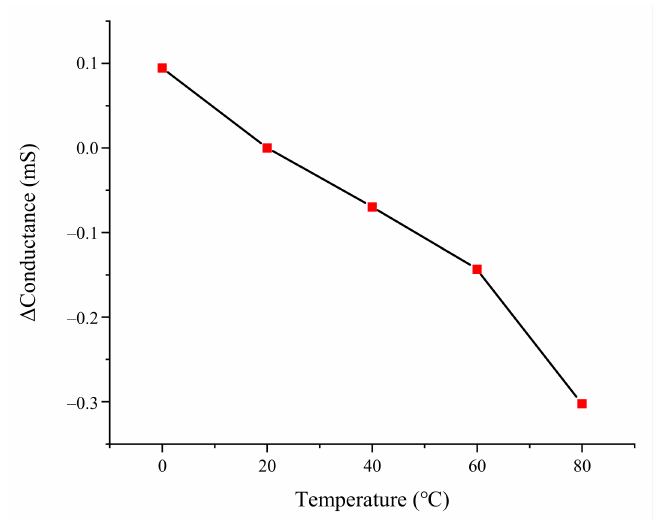
Figure 10. Thermal zero drift of the sensor.